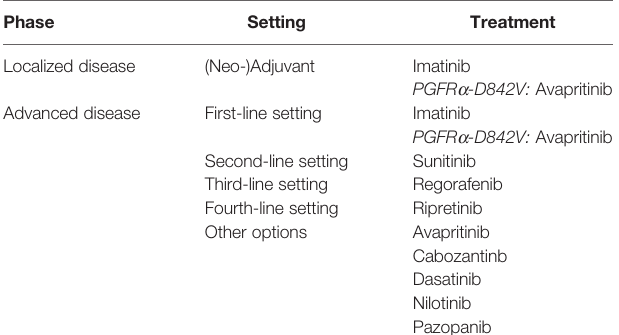
TABLE 1 | Therapeutic options in the treatment of gastrointestinal stromal tumors (NCCN Guidelines, October 2020). Phase Setting Treatment Localized